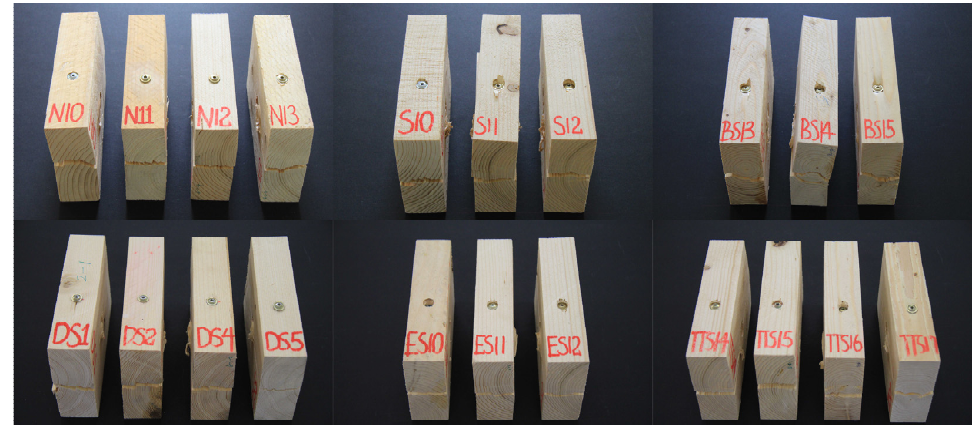
Figure 7. Embedment of screw head of a part of specimens from each group.